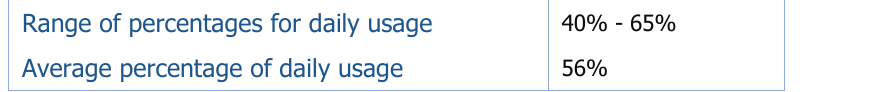
Table 6. Percentages for Youth’s Daily Electronics Usage Range of percentages for daily usage